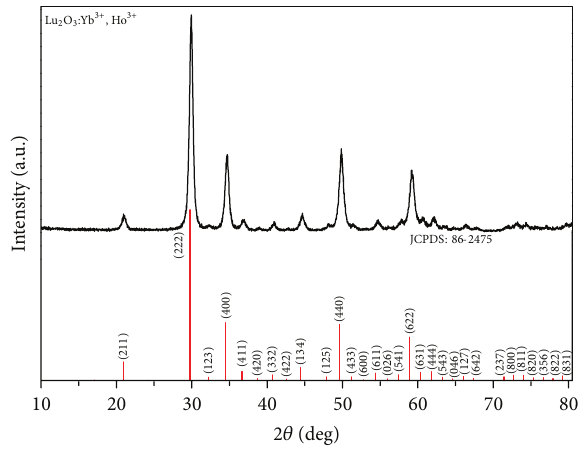
Figure 1: XRD patterns of Yb 3+ and Ho 3+ codoped Lu 2 O 3 powder obtained via a hydrothermal approach (black line); the red lines indicate the standard data of pure cubic Lu 2 O 3 structure (JCPDS: